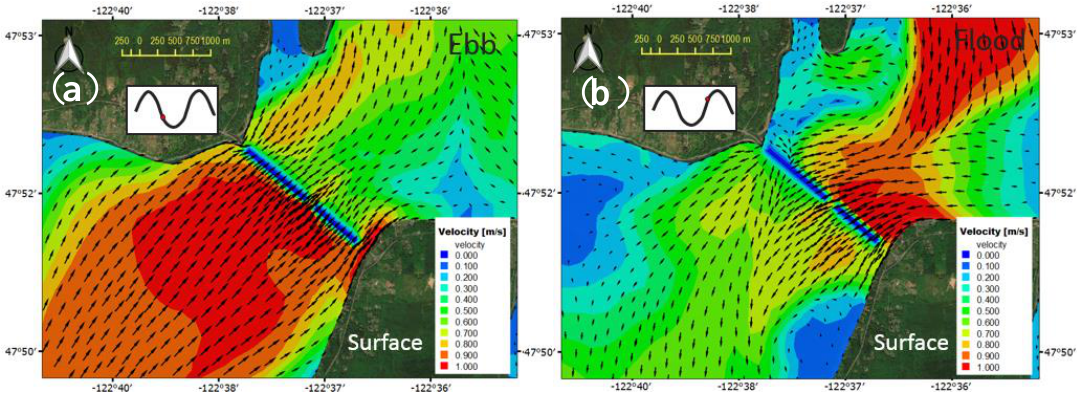
Figure 15. Predicted horizontal velocity contour and vector plots for test 2 scenario with HCB present and middle span open for ( a ) ebb and ( b ) flood currents in the surface layer. (Typical spring tide on 27 April 2017).